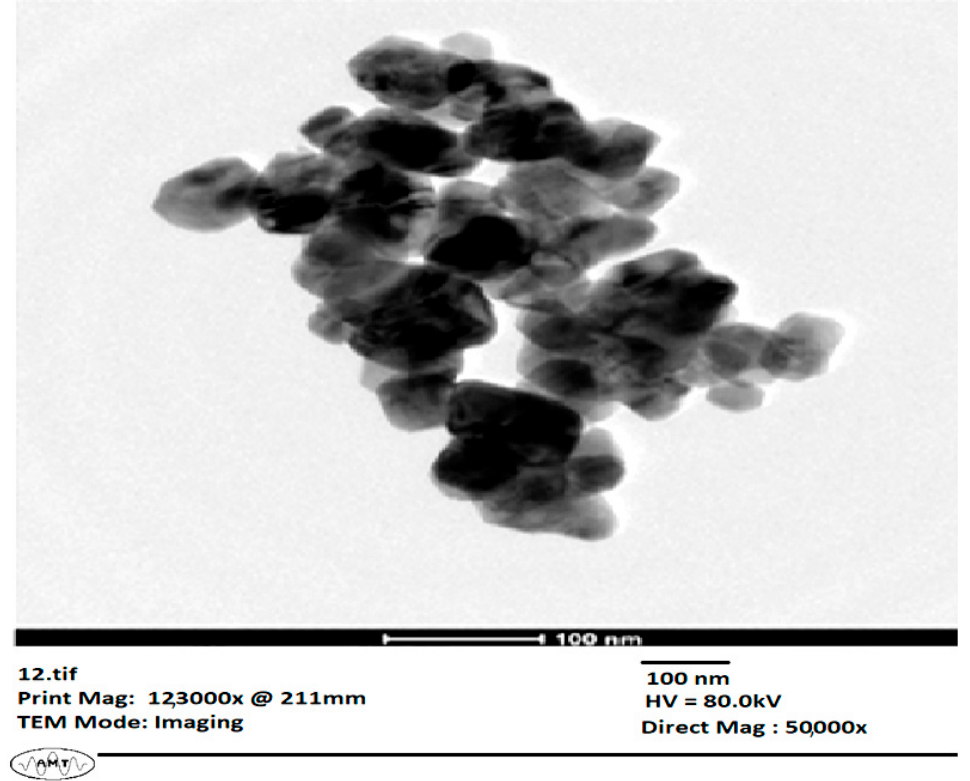
Figure 3. TEM image of CSNPs/PVP/CoONPs coating.